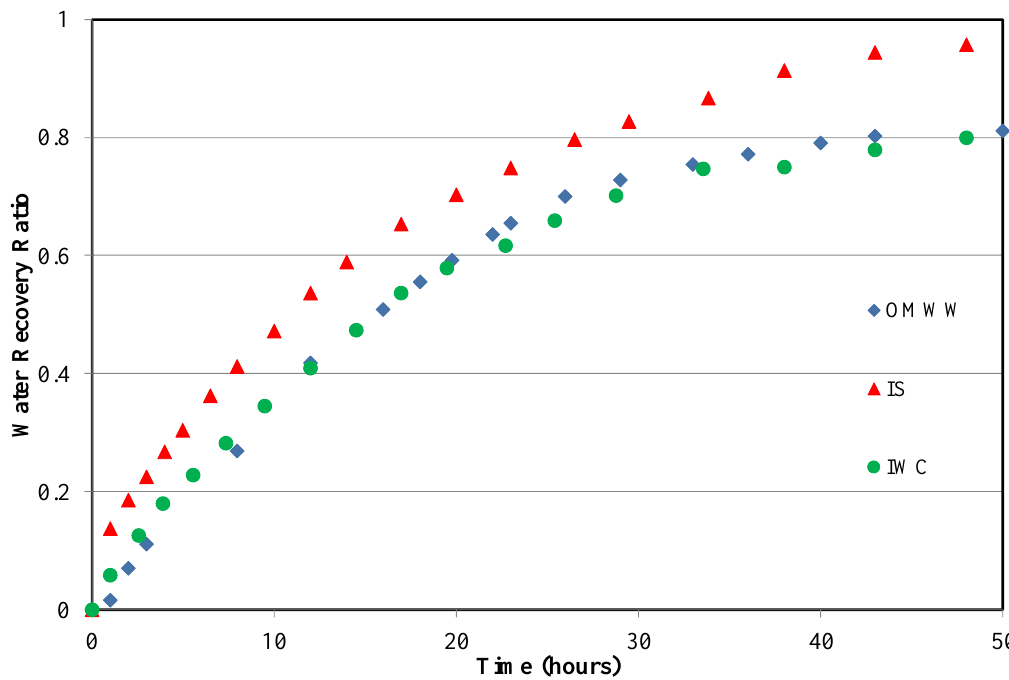
Figure 6. Water recovered ratio during drying for OMWW, IS, and IWC.